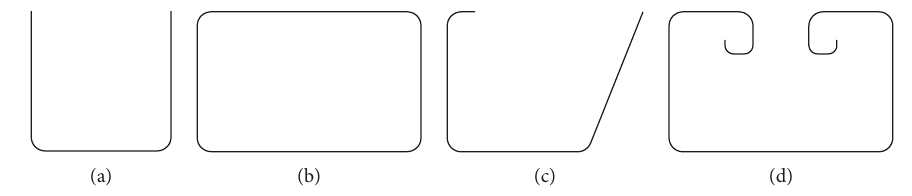
Figure 2: Cross section of the roll forming of the traditional commercial vehicle anticollision beam.